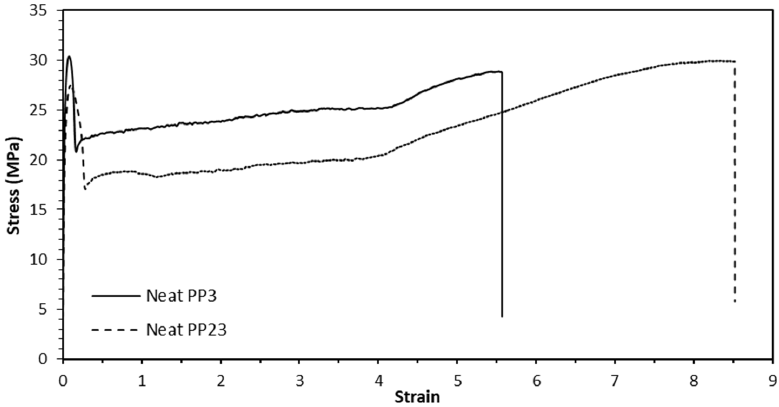
Figure 9. Typical stress-strain curves for neat PP3 and PP23. Table 3. Mechanical properties of the neat polypropylenes.